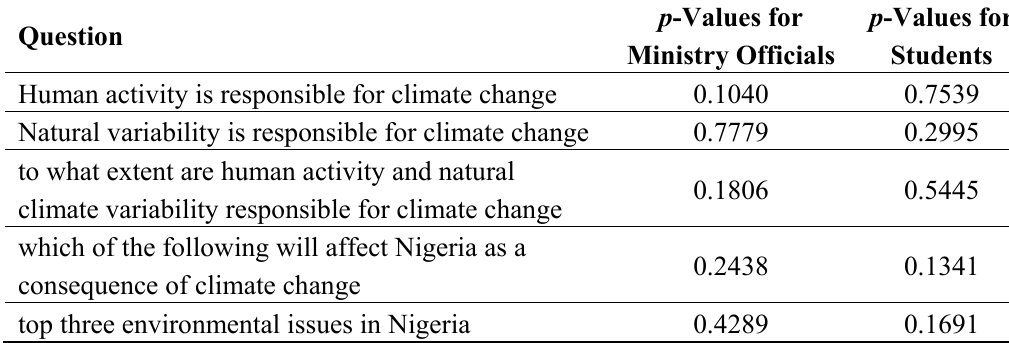
Table 8. p -values for the comparison of responses of ministry officials and students in Lagos and Akwa